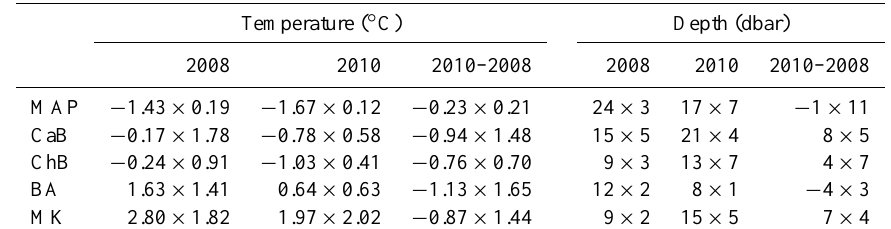
Table 2. Temporal evolution of the NSTM characteristics in the five areas between 2008 and 2010. Note that the average value of NSTM being calculated on a different number of points in 2008 and 2010, the average value of NSTM (2010)–NSTM (2008) is not equal to the difference between the average value of NSTM (2010) and the average value of NSTM (2008). This remark stands for the other variables.